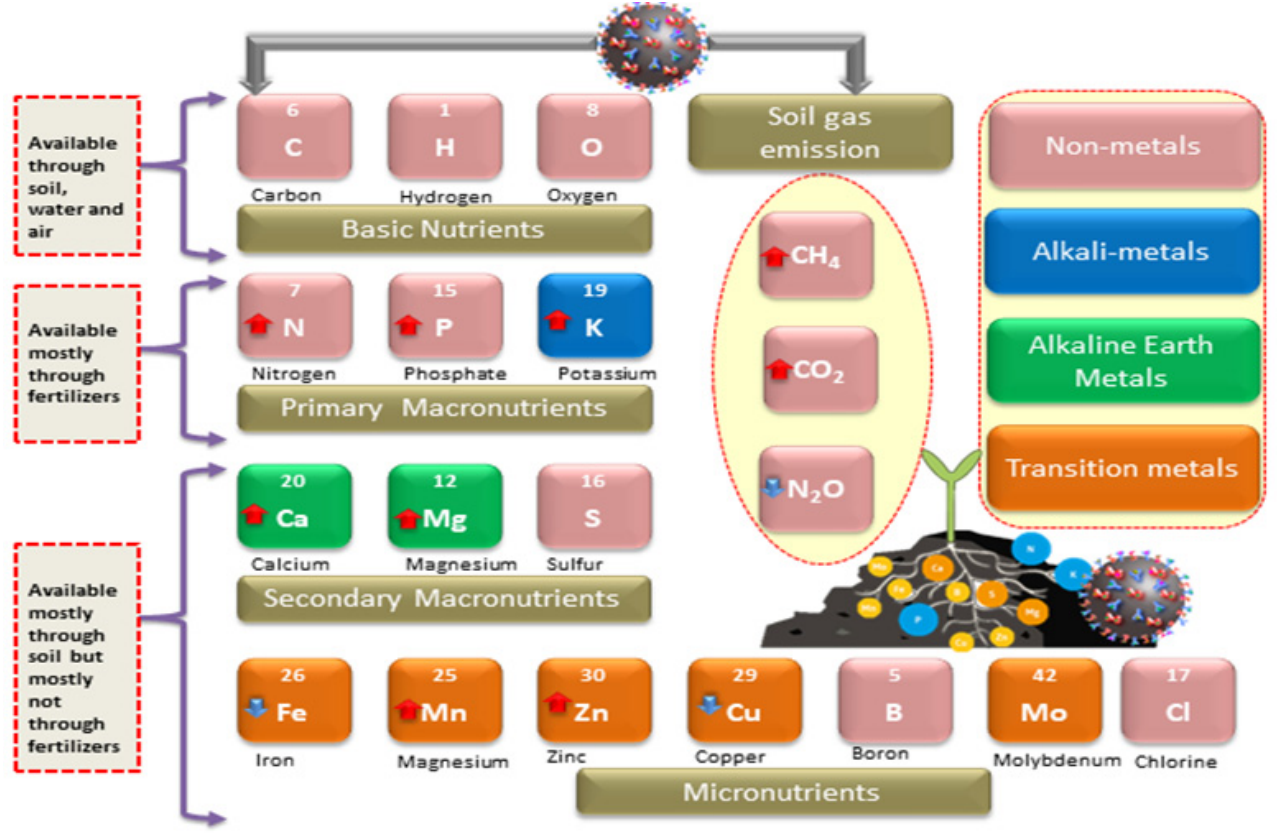
Figure 2. The effect of modified biochar on soil gas exchange and nutrient profile. The red color arrow represent increase, while blue arrow shows decrease in the nutrient content and gas emis- sion.